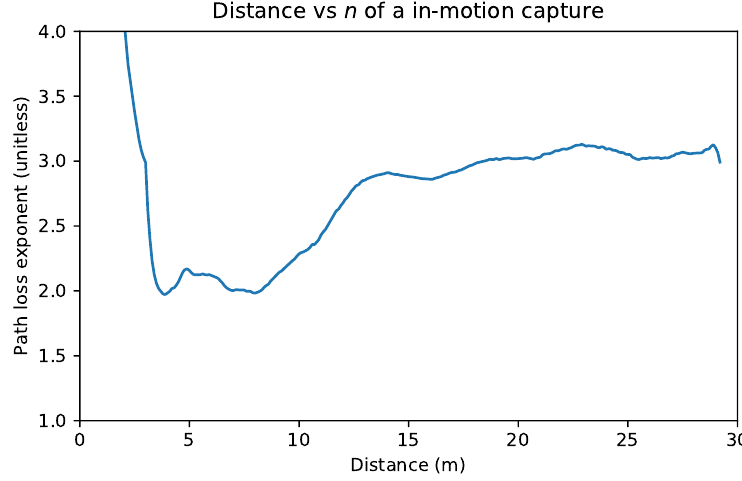
Figure 3. Path loss exponent value vs distance of a in-motion